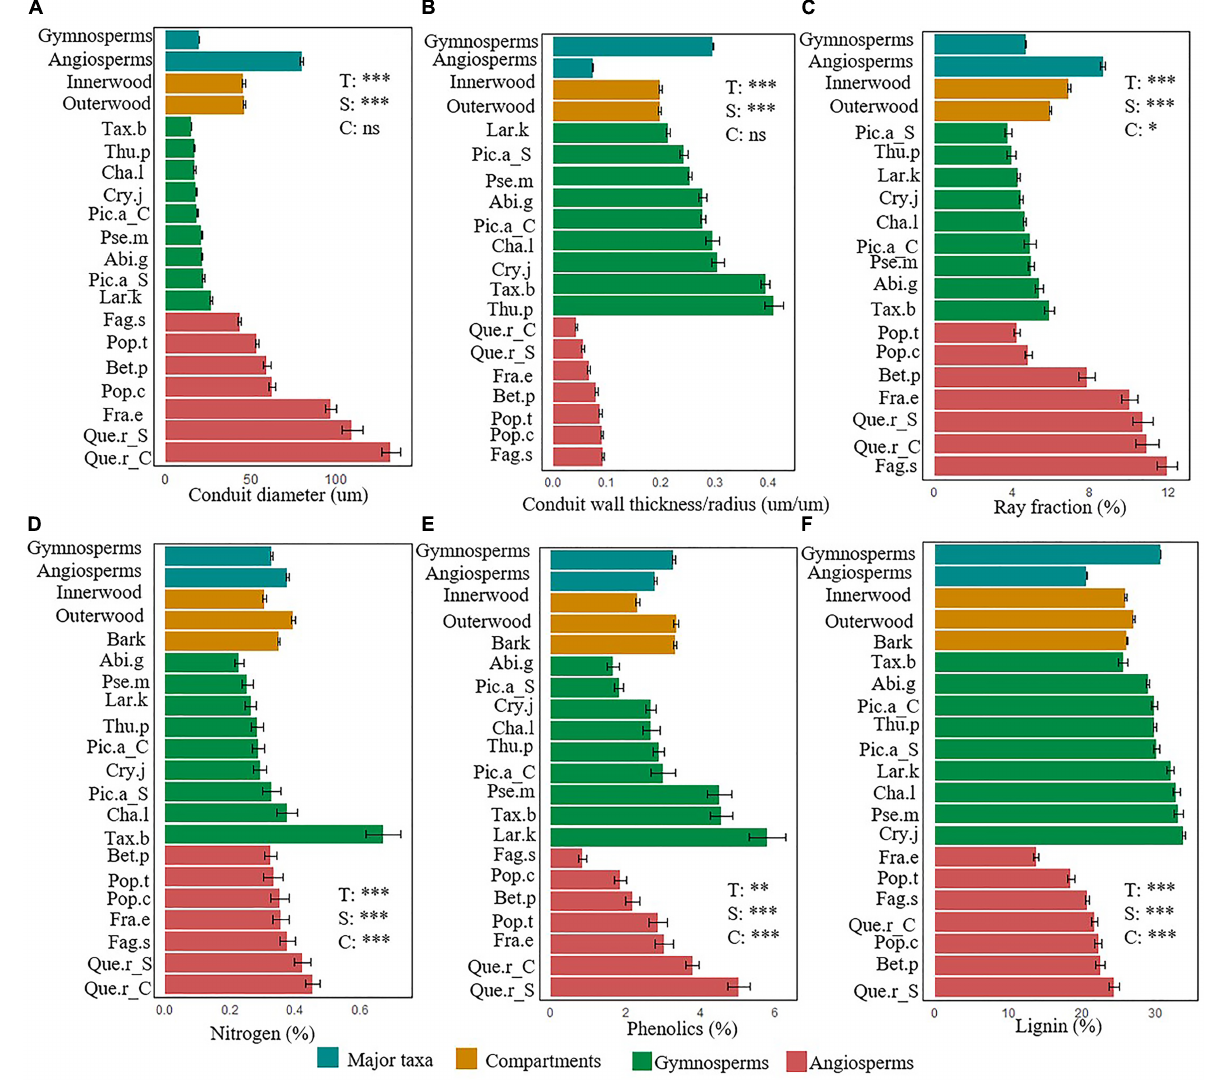
FIGURE 1 | Trait variation between two major taxa (gymnosperms vs. angiosperms; blue-green), across different stem compartments (inner wood, outer wood, and bark; brown) and species nested in major taxa (gymnosperms dark green, angiosperms reddish brown). For each of the six stem functions, one representative trait is shown: (A) conduit diameter, (B) conduit wall thickness/radius ratio, (C) ray fraction, (D) nitrogen, (E) phenolics, and (F) lignin concentrations. Means and SE of the mean are shown. T, Major taxa; S, Species nested within taxa; C, Compartments. ∗∗∗ P < 0.001, ∗∗ P < 0.001, and ∗ P < 0.05, ns, not significant. For species abbreviations see Table 1